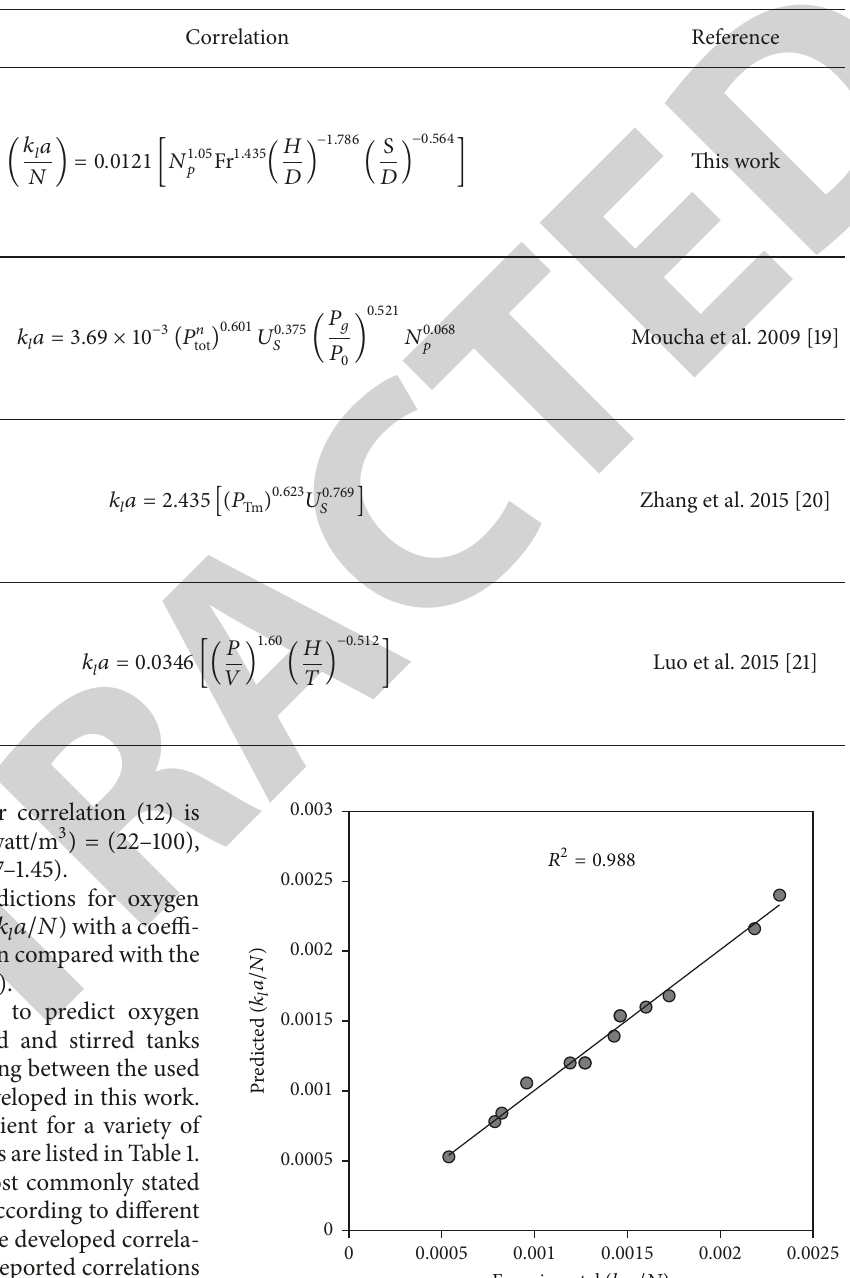
Figure 2: Comparison between the ( 𝑘 𝑙 𝑎/𝑁 ) values predicted by the correlation (12) with the experimentally resulting ( 𝑘 𝑙 𝑎/𝑁 ) values (each point in the figure represents four results at the same tested